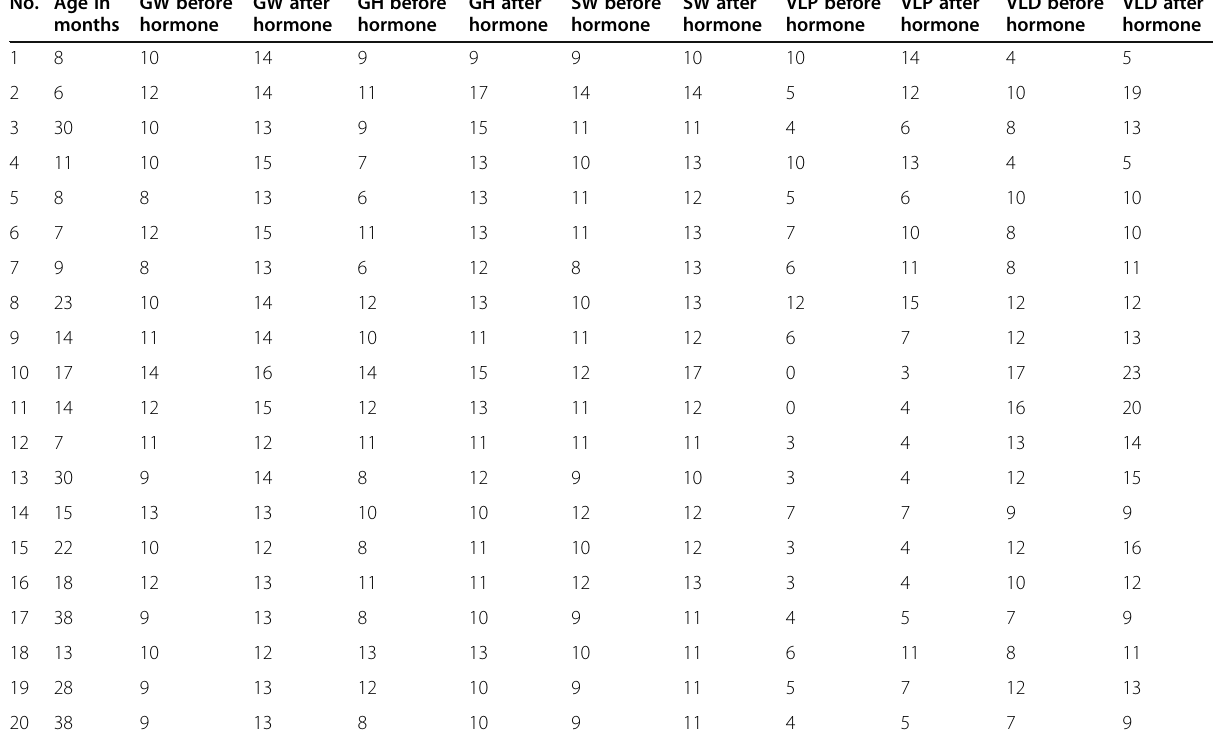
Table 1 Penile measurements before and after hormonal therapy. Penile measurements included glanular width (GW), glanular height (GH), shaft width (SW), ventral penile length proximal to meatus (VLP), and ventral penile length distal to meatus (VLD) No. Age in GW before GW after GH before GH after SW before SW after VLP before VLP after VLD before VLD after months hormone hormone hormone hormone hormone hormone hormone hormone hormone